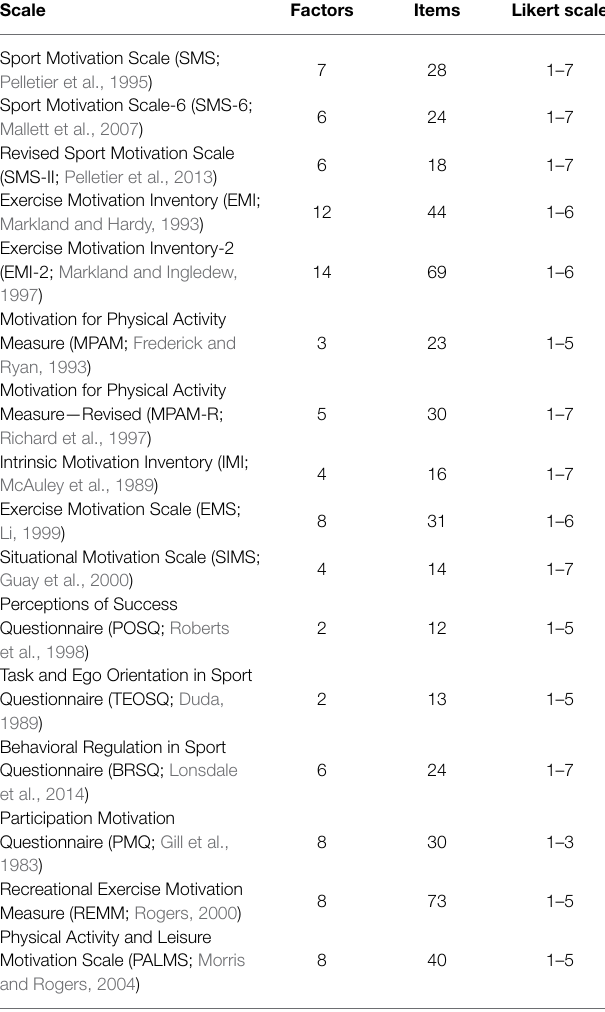
TABLE 2 | Overview of motivation measures in sports and